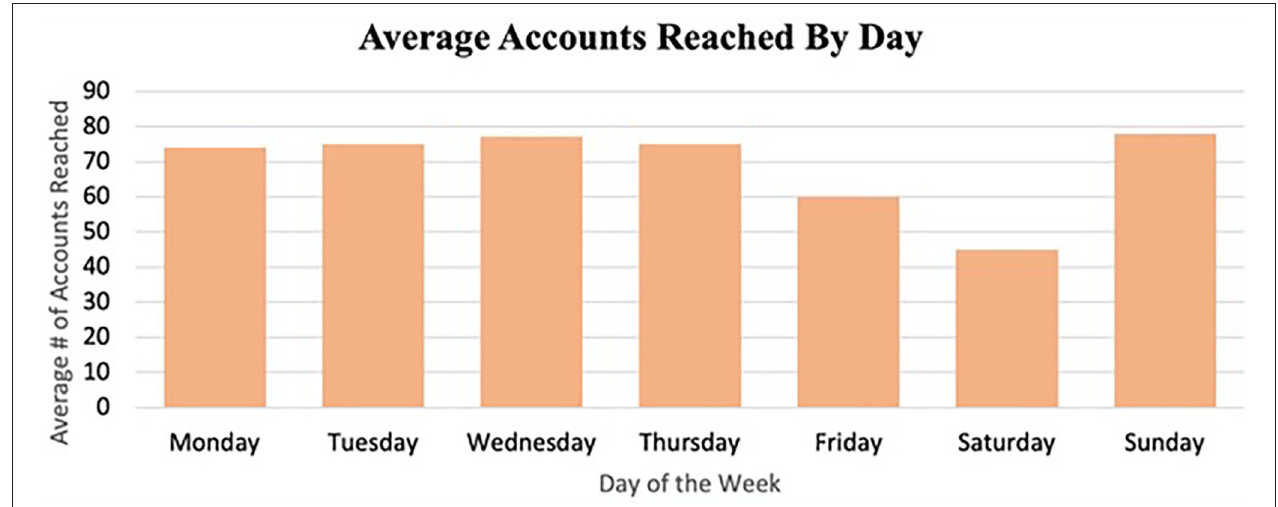
FIGURE 4 | Average accounts reached by day.